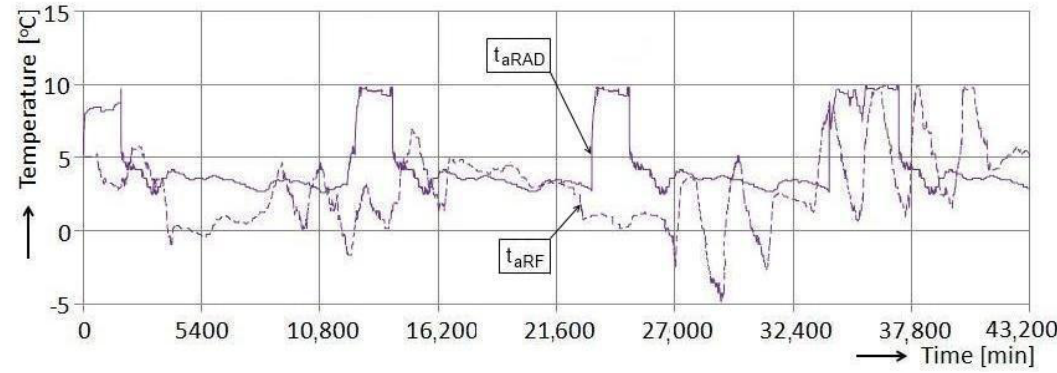
Figure 7. Recorded outdoor air temperature during heating